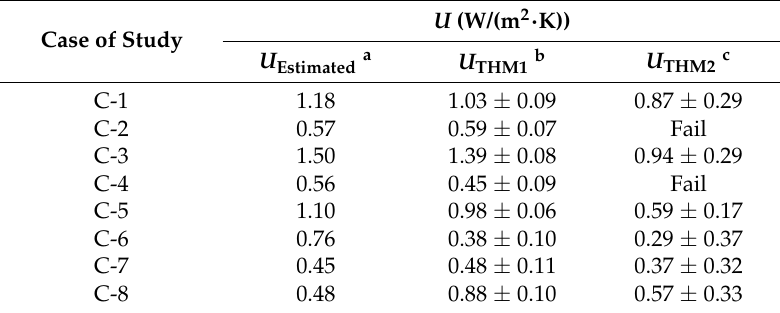
Table 4. Comparison of the obtained thermal transmittance